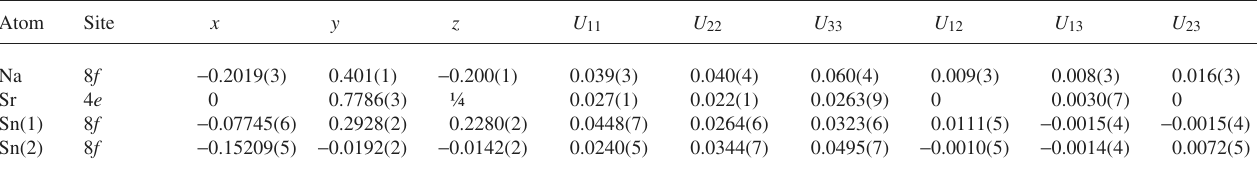
Table 2. Atomic coordinates and displacement parameters (in Å 2 )